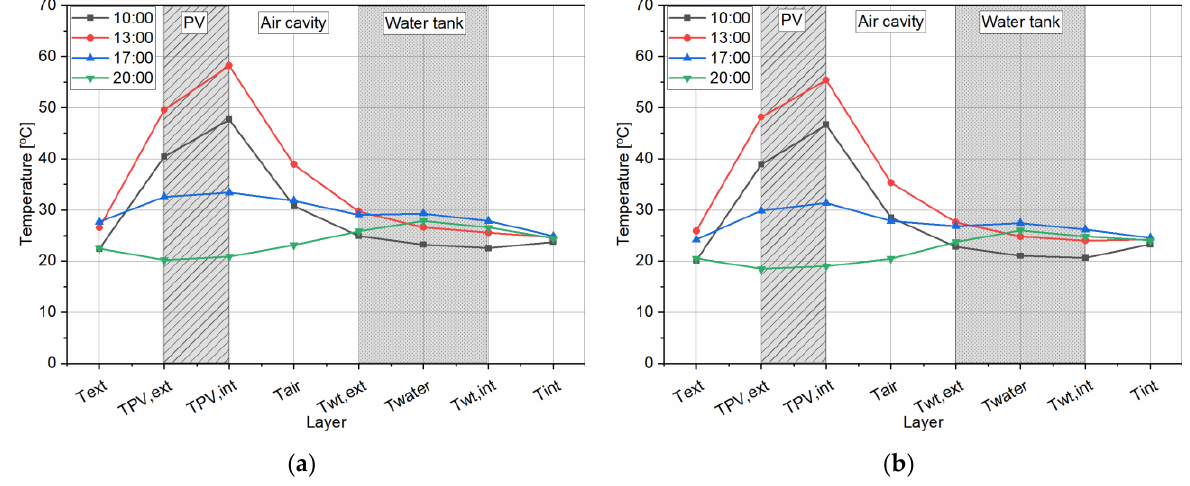
Figure 10. BIPV-WS thermal behavior: ( a ) August 22nd, non-ventilated air cavity; ( b ) August 30th, ventilated air cavity.